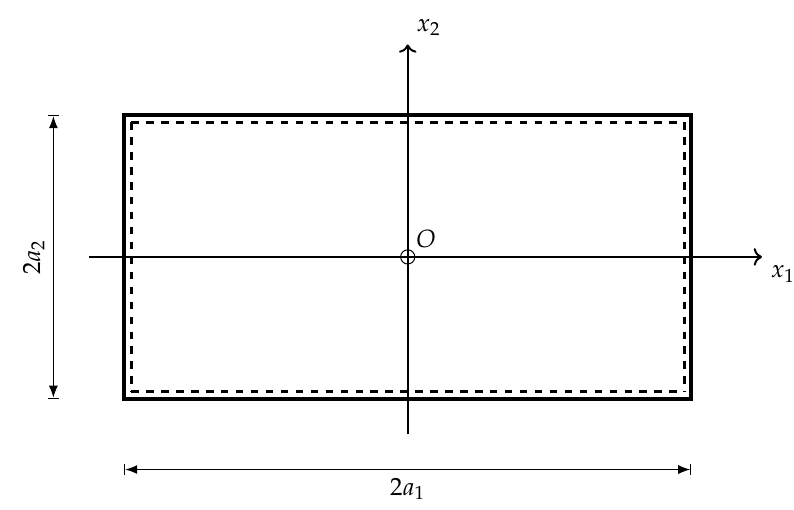
Figure 12. Simply supported rectangular plate.